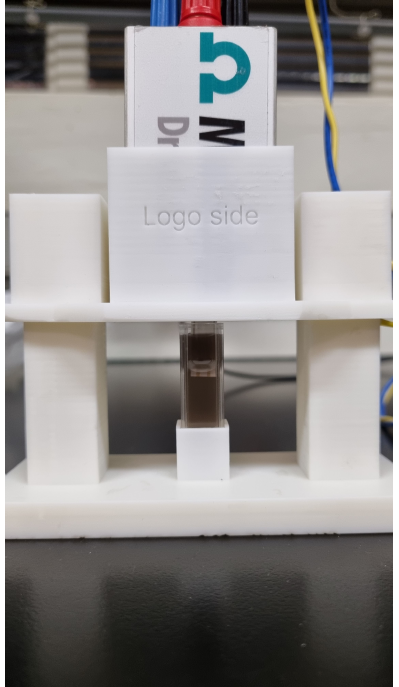
Figure 1. Custom 3D-printed jig for electrical measurements, showing the electrode connector keeping an electrode in suspension in a cuvette with a 1.8 mL